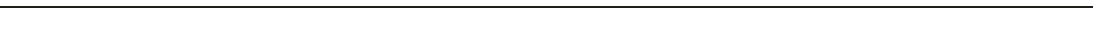
Fig. 1 Mutation of kun54 leads to excessive lipid accumulation. a – c rrp-8 ( kun54 ) is a mutant strain obtained from a forward genetic screen of fat regulators by EMS mutagenesis. Compared with wild-type (WT) worms, rrp-8 ( kun54 ) worms consistently show increased lipid accumulation by a Nile Red staining, b LipidTox Red staining, and c Oil Red staining of fi xed worms. The stained particles are lipid droplets (LDs) in representative 1-day-old adult worms. Scale bar represents 20 μ m. Magni fi cation, × 400. d Distribution of the lipid droplet size (% lipid droplets), as measured from Nile Red staining of fi xed worms from a . Data are presented as mean±SD of 10 animals for each worm strain. e Lipid contents were quanti fi ed by TLC/GC and presented as the percentage of triacylglycerol (% TAG) in total lipids (TAG + phospholipids, PL). Data are presented as the mean±SD of four biological repeats. f Genetic mapping of the kun54 mutation (the mapping details are shown in Supplementary Fig. 1) and the mutated position of kun54 in T07A9.8 is indicated by an asterisk. g Information for generation of the rrp-8 ( kun122 ) mutation. Top panel: schematic diagram of the generation of the kun122 mutation (42bp deletion) using CRISPR/cas-9 technology. The red arrow indicates the site of the designed sgRNA. Bottom panel: Nile Red staining of fi xed worms. h Distribution of the lipid droplet size (% lipid droplets), as measured in Nile Red-stained fi xed worms from g . Data are presented as the mean±SD of 10 animals for each worm strain. i Nuclear localization of RRP-8::GFP with DAPI (upper panel, fl uorescence microscopy) and the nucleolar marker mCherry::FIB-1 (lower panel, confocal microscopy). Scale bar represents 10 μ m in upper panel and 20 μ m in lower panel. j Fluorescence microscopy of nuclear expression of RRP-8::GFP { kunEx121 [Prrp-8 :: rrp-8 :: gfp] } throughout different developmental stages (embryo to L4 larvae). In all of the represented animals, the anterior is indicated on the left and posterior is indicated on the right. Signi fi cant difference between WT and a speci fi c worm strain, Student ’ s t -test, *** P